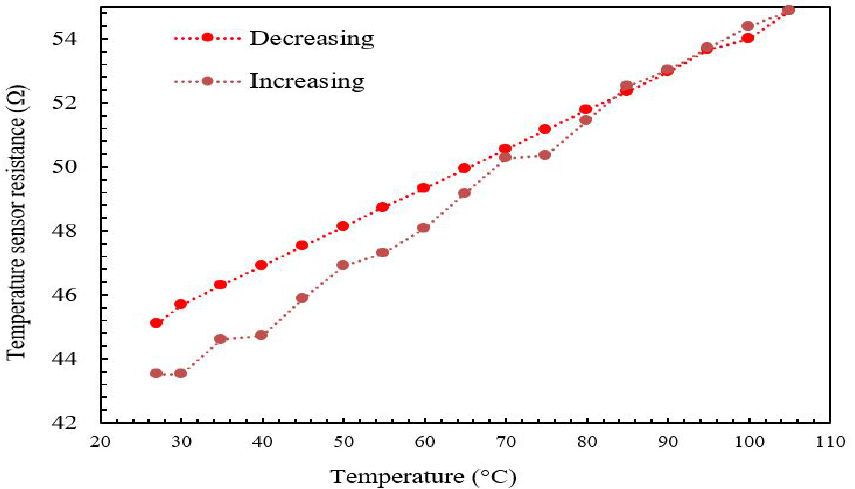
Figure 17. Experimental for the gold temperature sensor versus increasing and decreasing temperature.